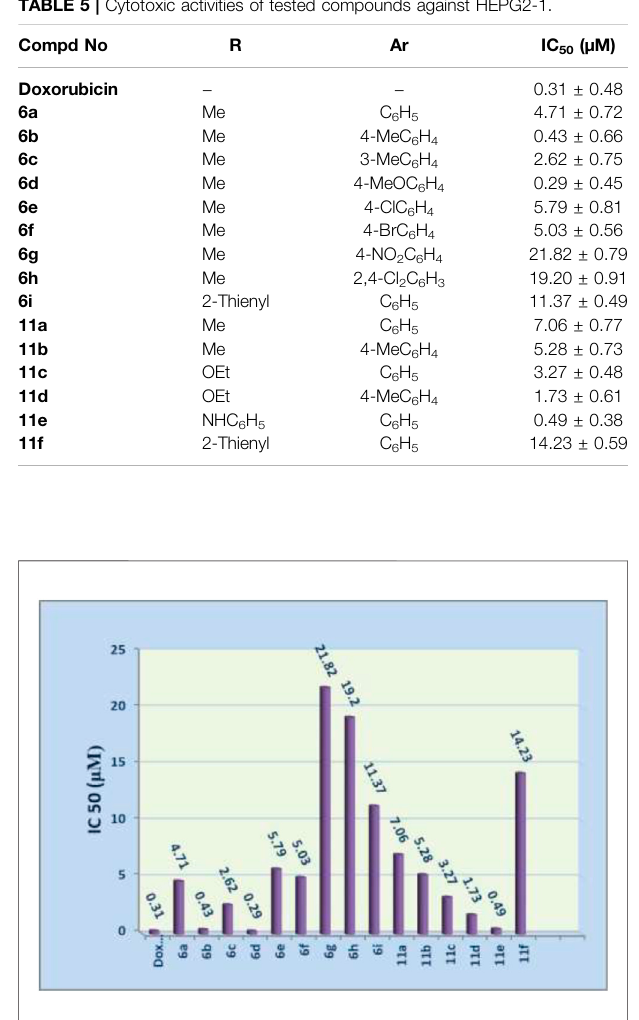
FIGURE3 | Cytotoxic activities oftested compoundsagainst HEPG2-1.